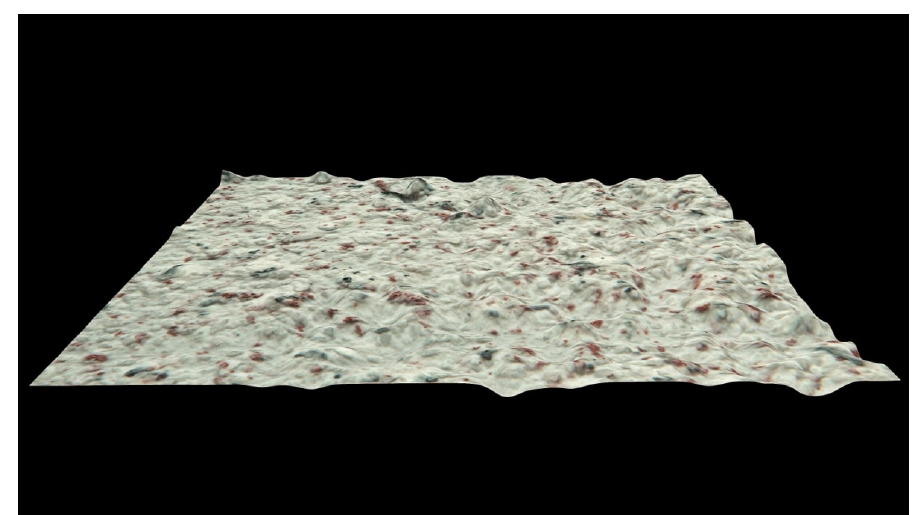
Figure 8. Paint surface with metal grains, 3D front view, Alcor R&D Center unpublished report, project No. POIR.01.01.01.00-636/20.